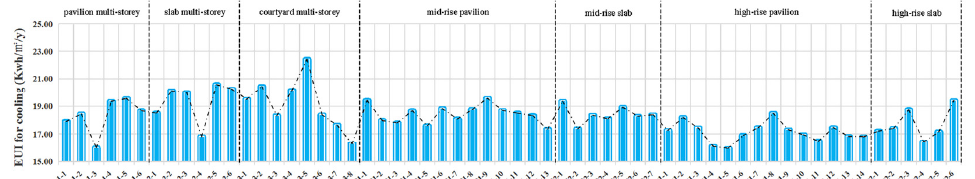
Figure 13. Distribution characteristics of EUI for cooling in seven typologies of office blocks.